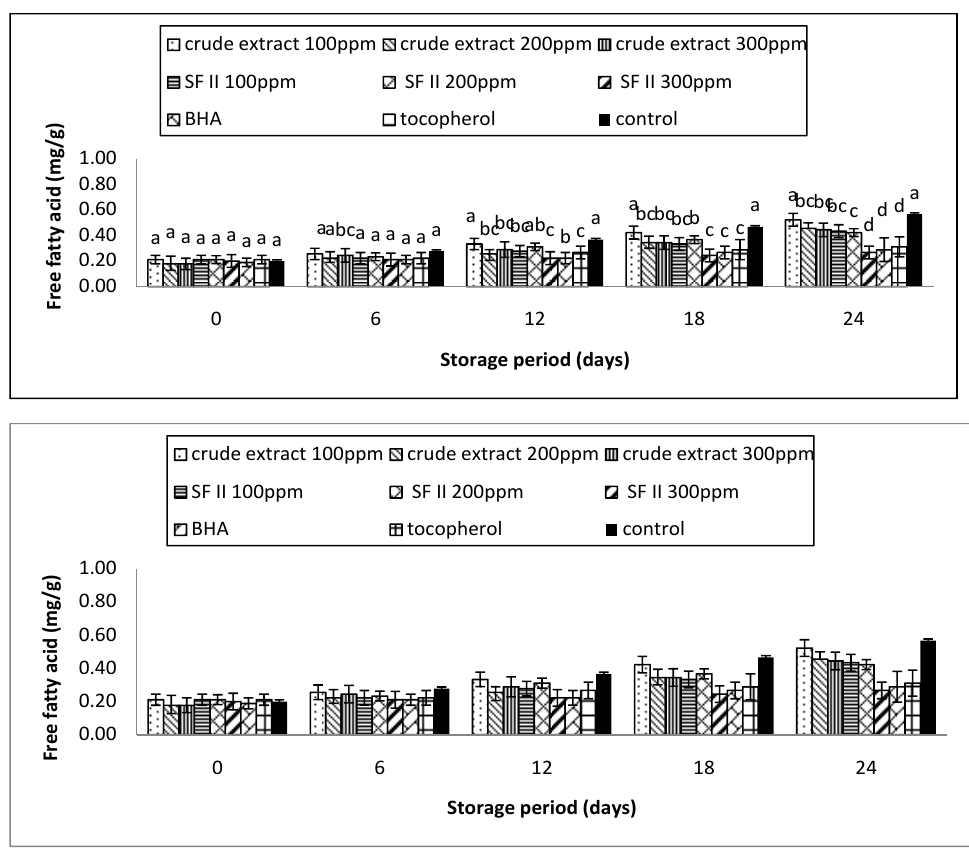
Figure 6. The free fatty acid of the supplemented sunflower oil with rambutan extracts, BHA and tocopherol under accelerated storage at 65 °C for 24